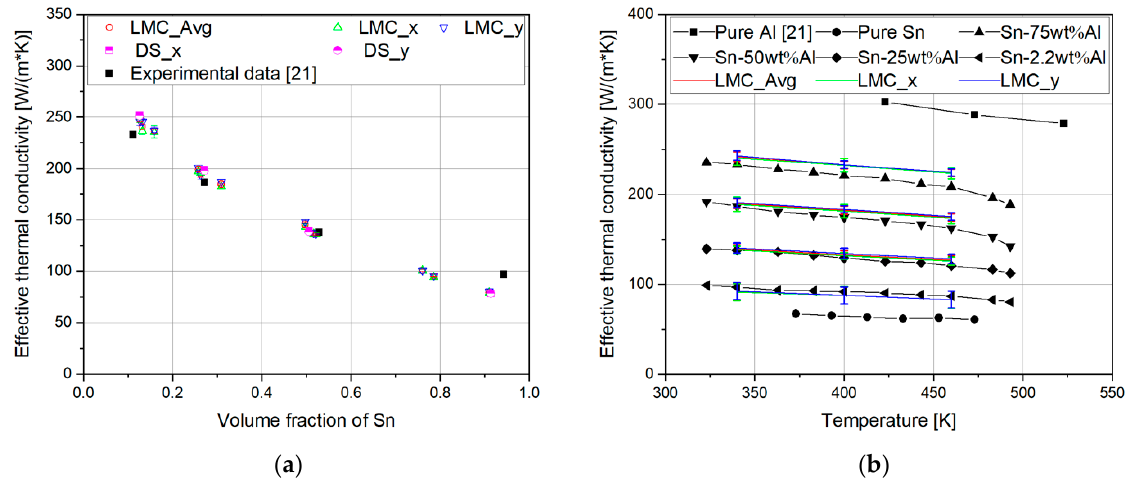
Figure 2. ( a ) Effective thermal conductivity of Al-Sn alloys vs. Sn volume fraction experimentally measured by Meydaneri Tezel et al. [20] at 340 K and estimated by the Lattice Monte-Carlo (LMC) method and direct simulation (DS) method at the same temperature. In addition to average values of effective thermal conductivity, those obtained along the horizontal (x) and vertical, (y) direction in their micrographs are given. ( b ) Experimental and calculated effective thermal conductivity as a function of temperature data for pure Al, pure tin, and for different Al-Sn alloys.